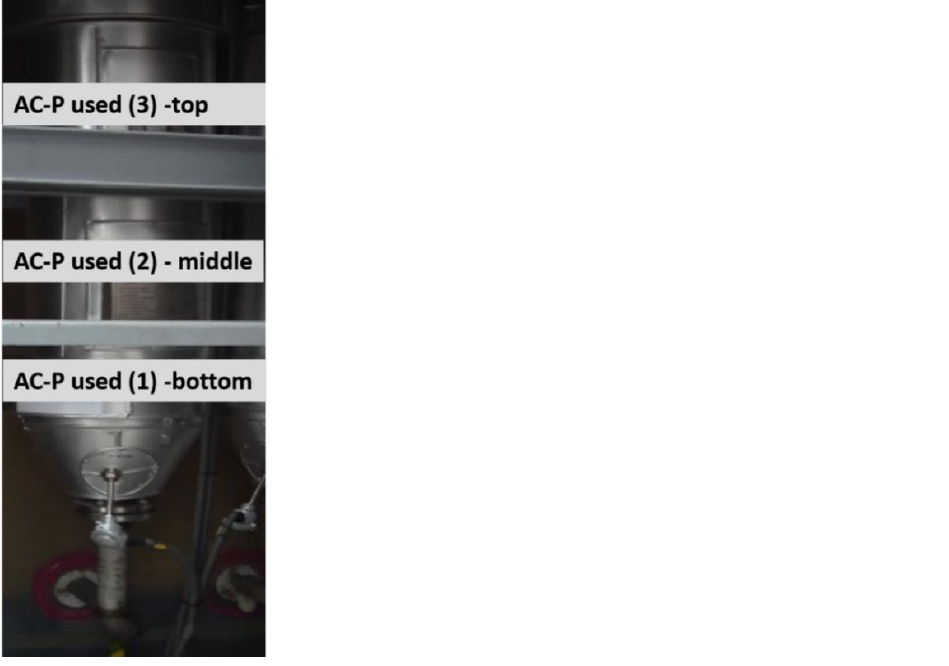
Figure 3. Retrieval locations for the activated carbon AC-P used as packing for the deSOx and deNOx adsorber in the pilot DR-VPSA CO 2 capture unit.